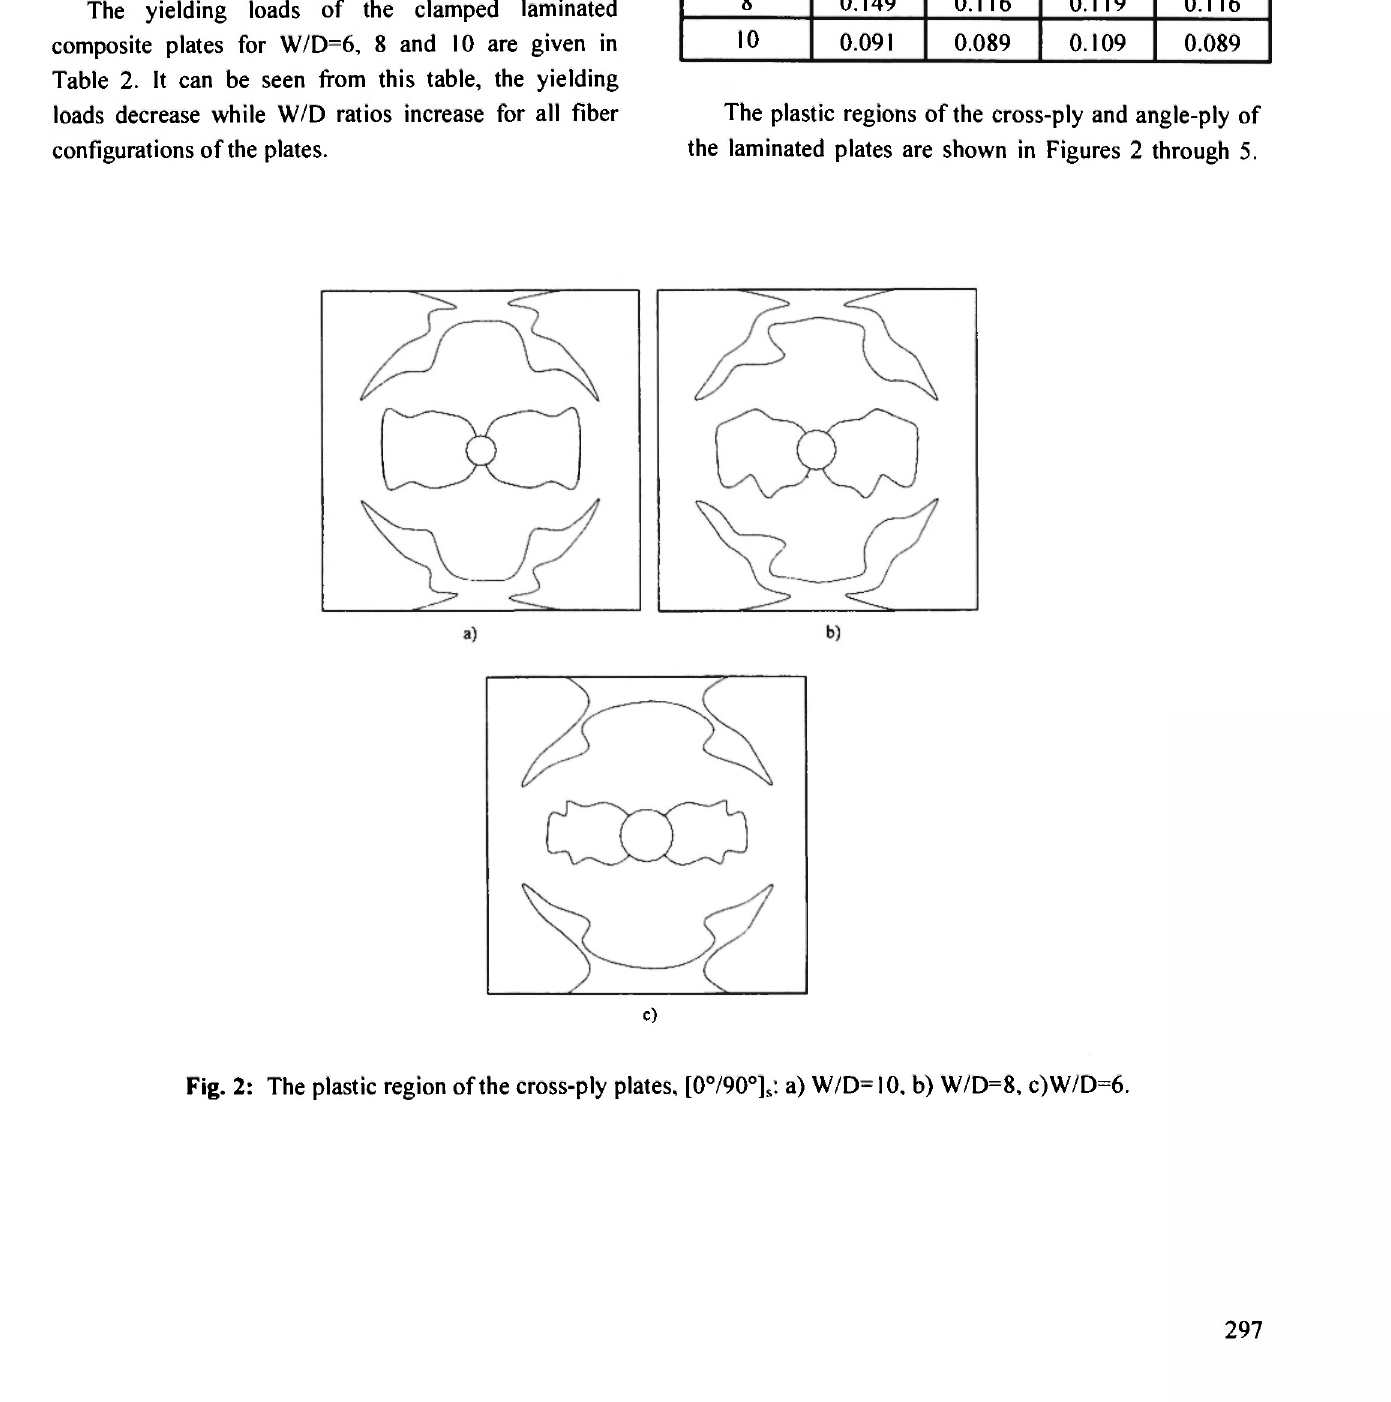
Fig. 2: The plastic region of the cross-ply plates, [0°/90°] s : a) W/D=I0, b) W/D=8,